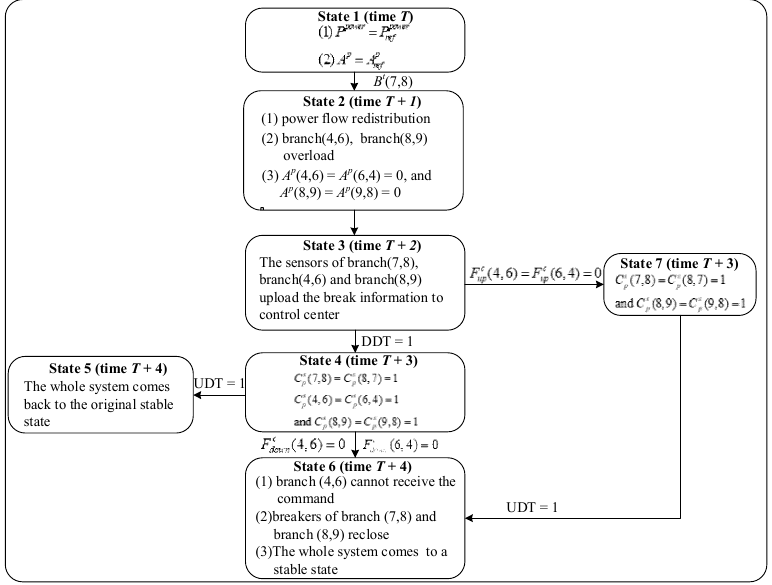
Figure 8. State machine of coupled faults state of CPPS.